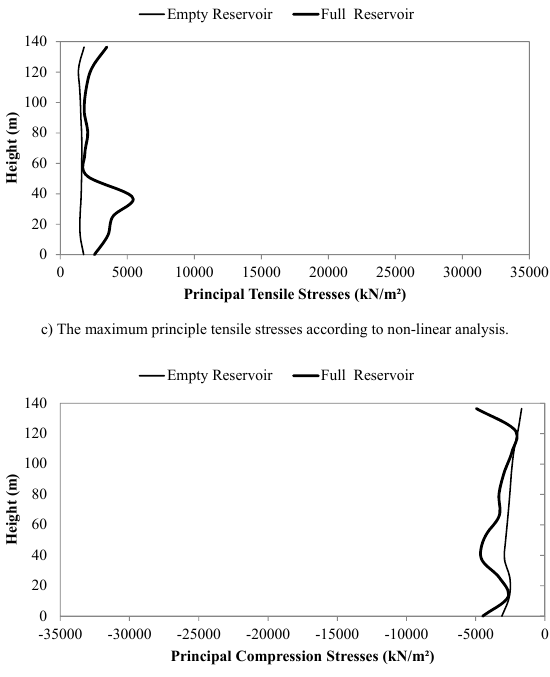
Fig. 26. The maximum principle compressive and tensile stresses during earthquake.